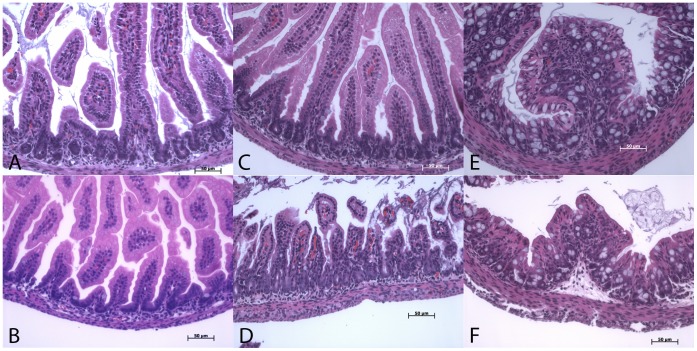
Gut histology of 1-week-old wild type (OCTN2+/+) and age-matched homozygous (OCTN2−/−) mice (H&E staining, X20).Images A–C represent photomicrographs of wild type (OCTN2+/+) jejunum, ileum and colon respectively and images D–F represent photomicrographs of homozygous (OCTN2−/−) jejunum, ileum and colon at the same magnification. (Bar represents 50 µm).